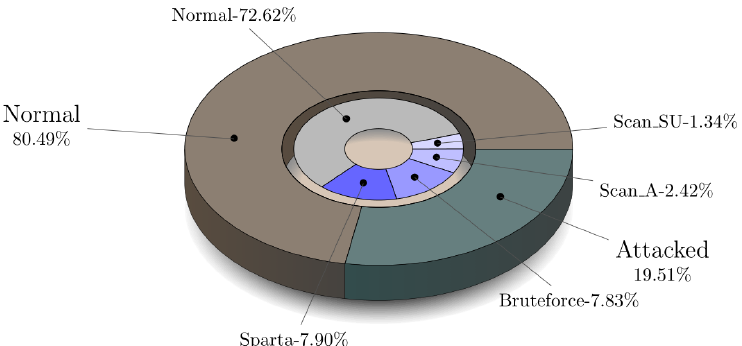
Figure 8. Five files statistics of